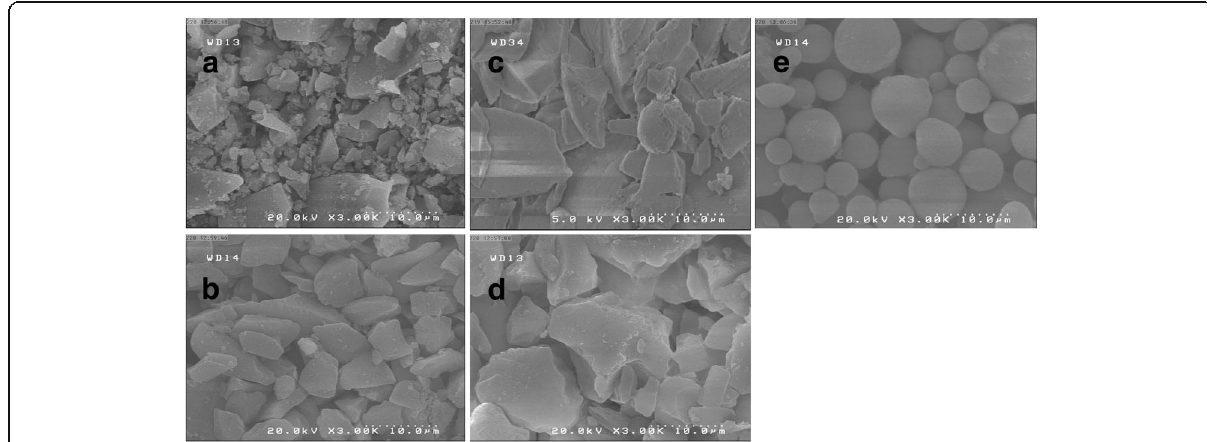
Fig. 1 Field-emission scanning electron photomicrographs of scraped silica. Magnification: 3000×. a Merck TLC plate. b Merck HPTLC plate. c MN TLC plate. d MN HPTLC plate. e Merck Lichrospher